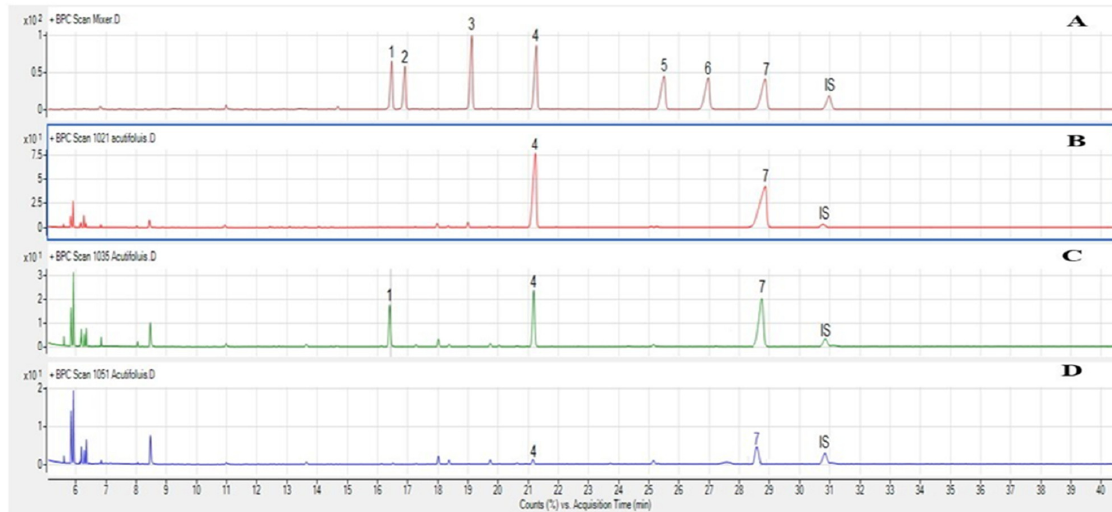
Figure 2. Chromatographic profile acquired by GC-MS of sugar standards ( A ), the major saponins detected in the hydrolyzed acid of A. acutifoius organs; ( B ), HTSAP-3, ( C ), HTSAP-6, ( D ), HTSAP-3 and ACSAP-1. 1: Rhamnose, 2: Fucose, 3: Arabinose, 4: Xylose, 5; Mannose, 6: Galactose, 7: Glucose, IS: Inter- standard; Inositol.